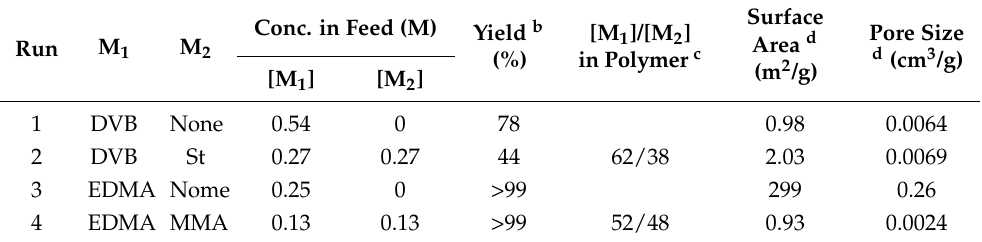
Conc. in Feed (M) Yield b